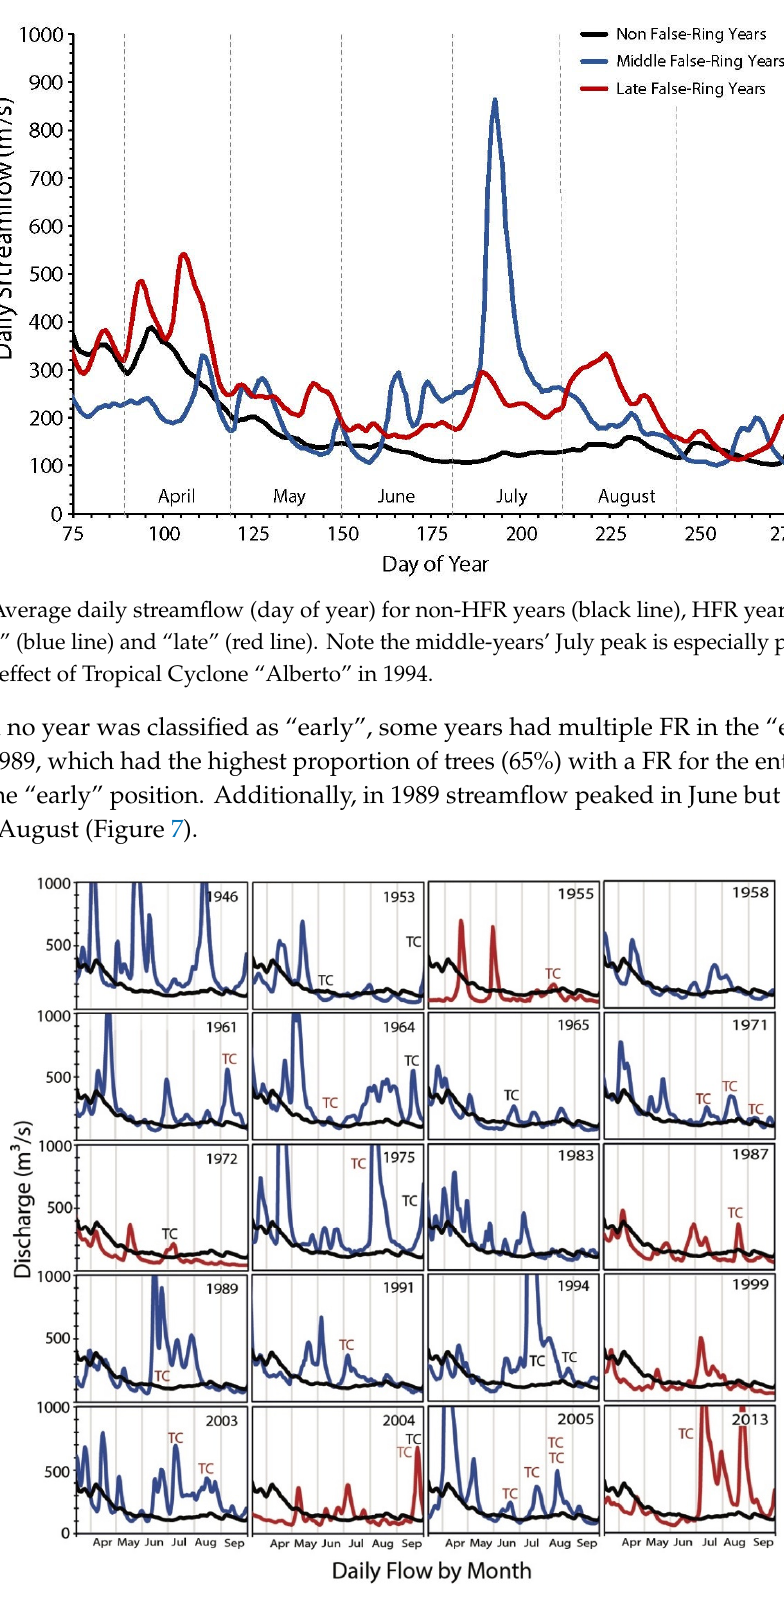
Figure 7. Daily streamflow values by month for individual HFR years (blue line = wide rings, red line = narrow rings) and non-HFR years (black line). Low spring discharge followed by above normal summer flows is clear in narrow ring years. Additionally, shown are TC events (black indicated in HURDAT data, red from TCR data).